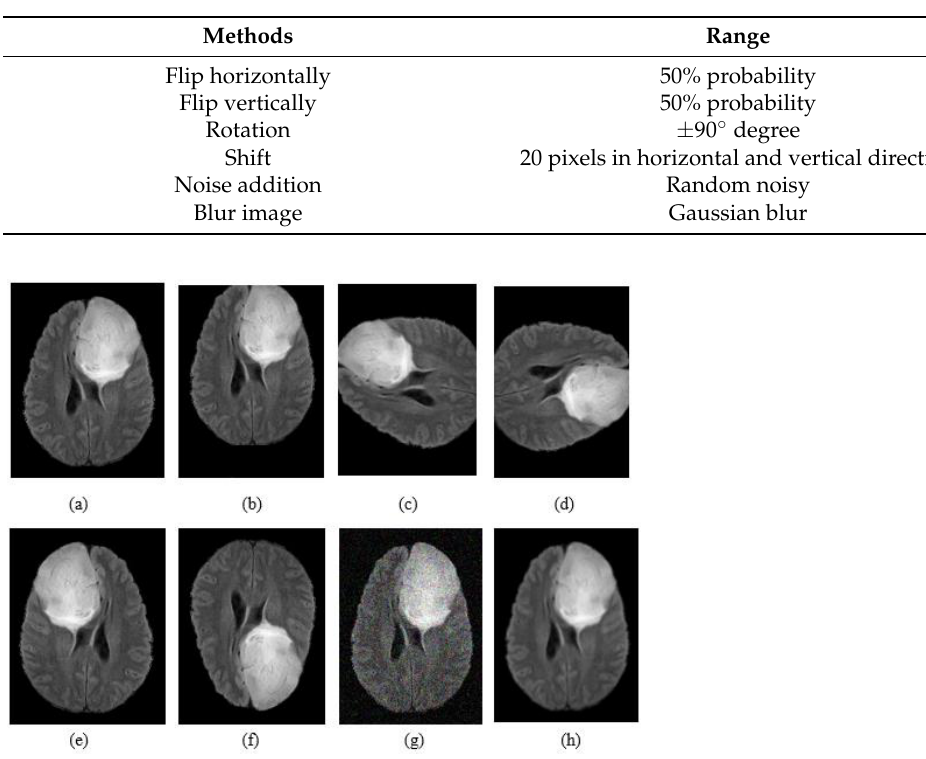
Table 2. Summary of the applied data augmentation methods.